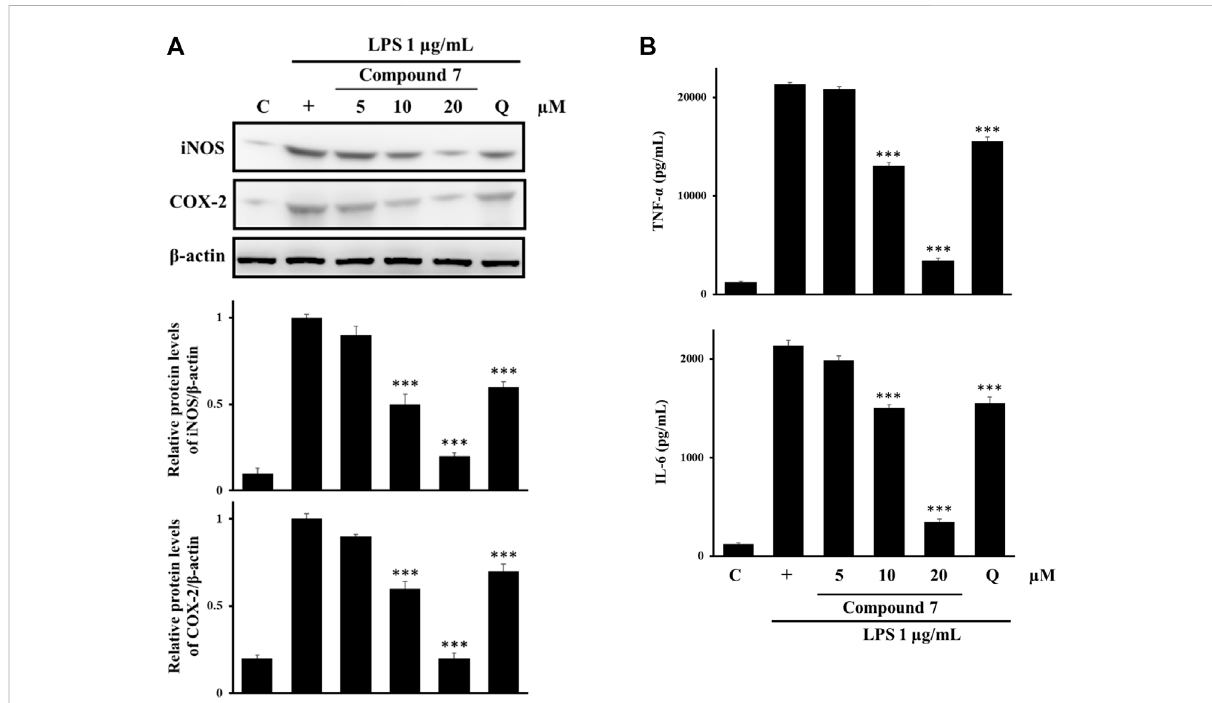
FIGURE 5 Effectsof 7 ontheexpressionoftheiNOSandCOX-2proteinsandcytokinesecretion.RAW264.7cellswerepretreatedwiththecompoundsfor 1 h followed by stimulation with LPS (1 μ g/ml) for an additional 24 h. (A) The expression of iNOS and COX-2 was determined using western blot analysis.TherelativelevelsofiNOSandCOX-2werequanti fi edbynormalizationtothe β -actinlevels. (B) ThelevelsofTNF- α